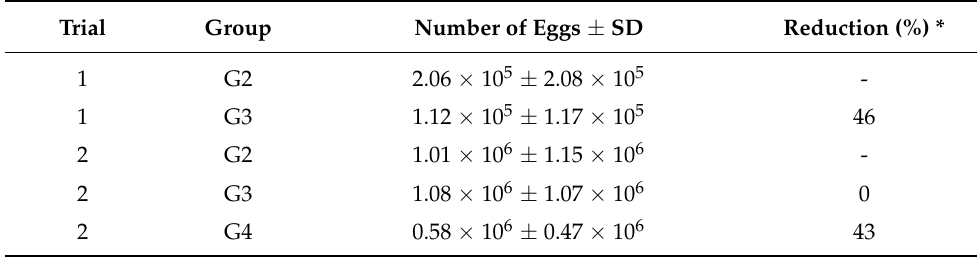
Table 3. Eggs recovered from gall bladder at necropsy.